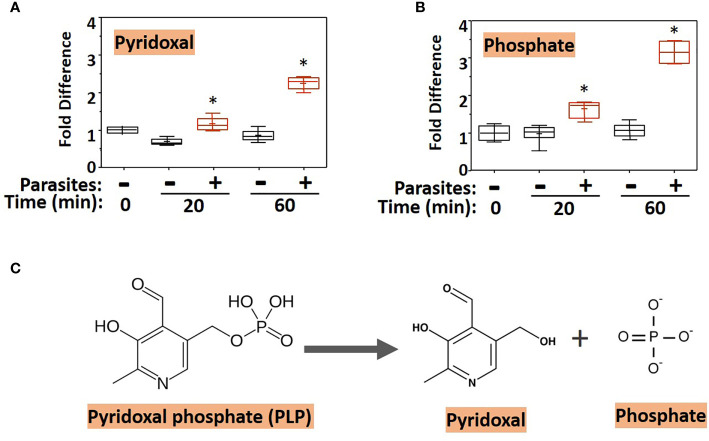
Box plots showing relative levels of pyridoxal (A) and phosphate (B) in murine plasma that either contained adult schistosomes (+, red) or did not contain schistosomes (-, black) for the indicated time periods. * indicates statistically significant difference compared to the same time point lacking parasites; Welch’s two-sample t-test, P < 0.05. Each box bounds the upper and lower quartile, the line in each box is the median value and “+” signifies the mean value for the sample; error bars indicate the maximum (upper) and minimum (lower) distribution. Values obtained at zero time (0) are set at 1. (C) Chemical structure of pyridoxal phosphate (PLP, left) and the products of its hydrolysis (indicated by the arrow), pyridoxal and phosphate (right).